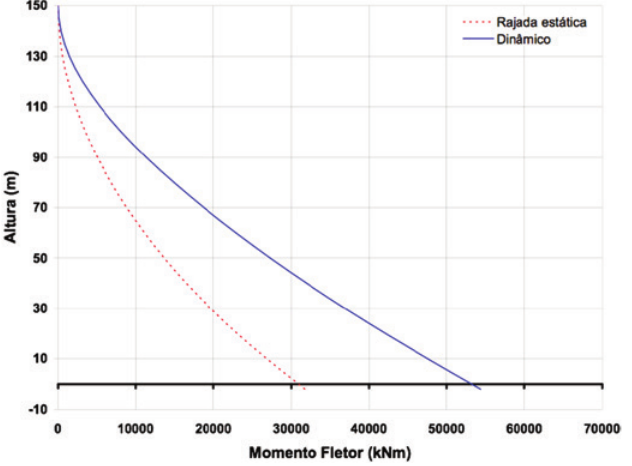
Figure 17 Comparison between the static gust method and the dynamic method for the isolated chimney with aerodynamic coefficients obtained from the wind tunnel